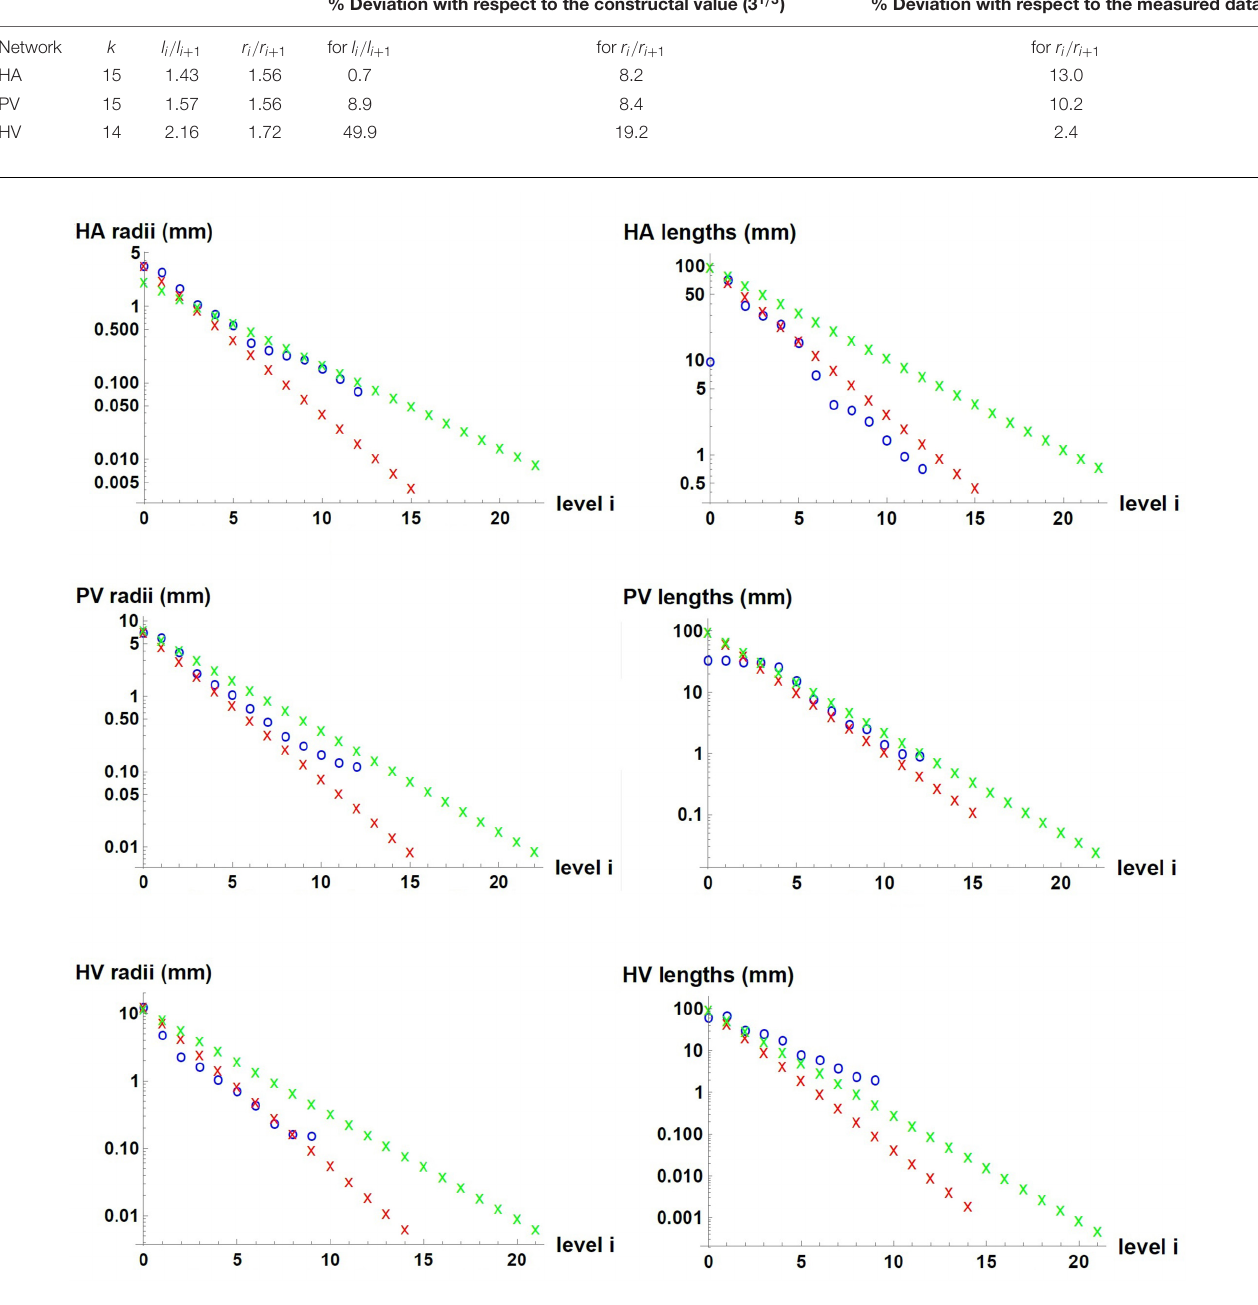
FIGURE 2 | Dimensions of the vessels in the three hepatic vascular networks. From top to bottom, the values for HA, PV and HV networks are presented. The radii (left hand side) and lengths (right hand side) of the vessels of each level i of the networks are shown. The red and green crosses represent the values obtained with our model for n = 3 and n = 2, respectively, and the blue circles, the available experimental measurements (Debbaut et al., 2011, 2014).